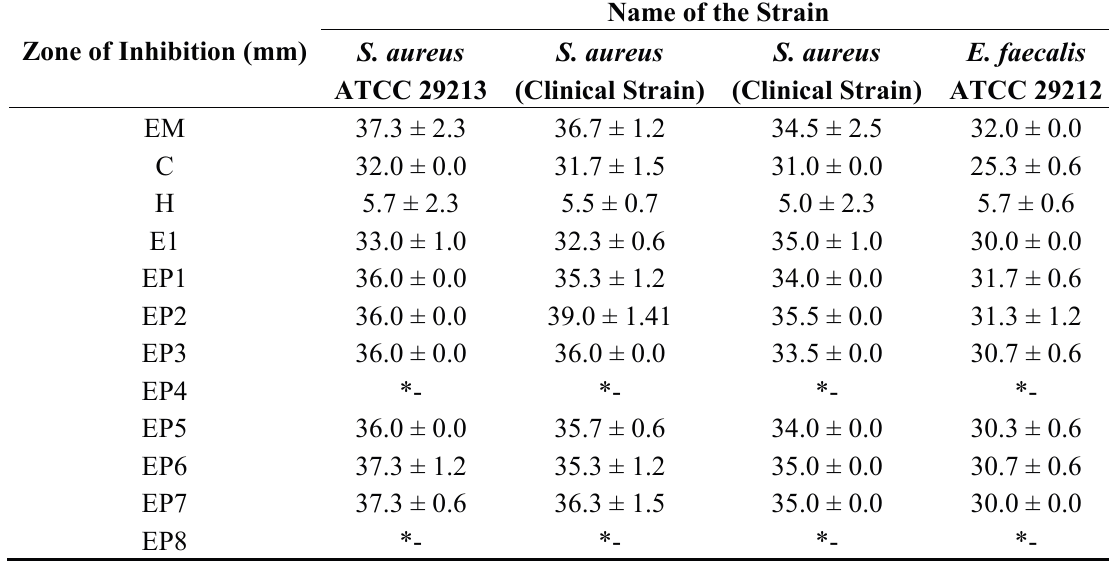
Table 4. Antibacterial activity of hydrogels with different concentrations of PAMAM-NH 2 G2 or